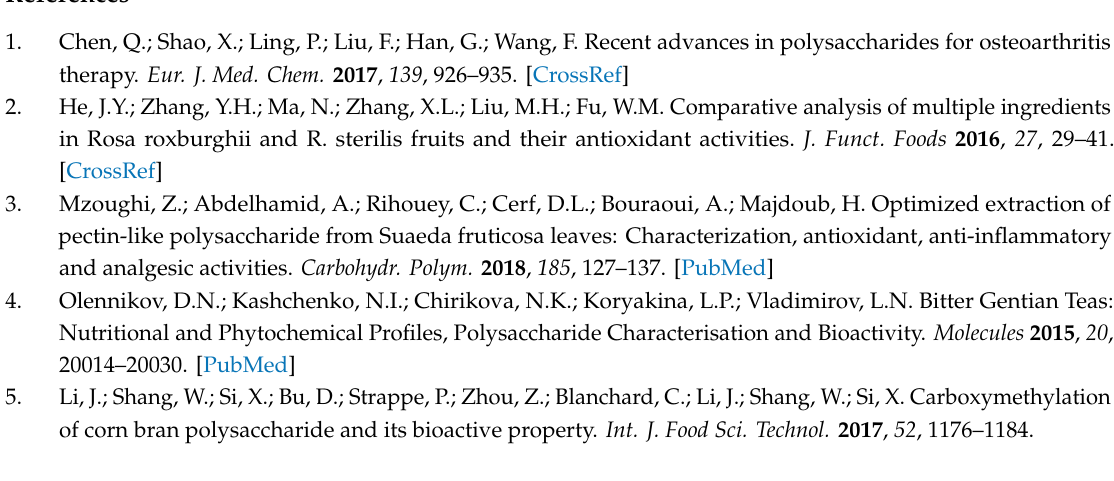
Supplementary Materials: The following are available online, Figure S1, The calibration curve of dextran standards and HPGPC of TMP-1-1 polysaccharide. Figure S2, GC-MS diagram of monosaccharide standard and